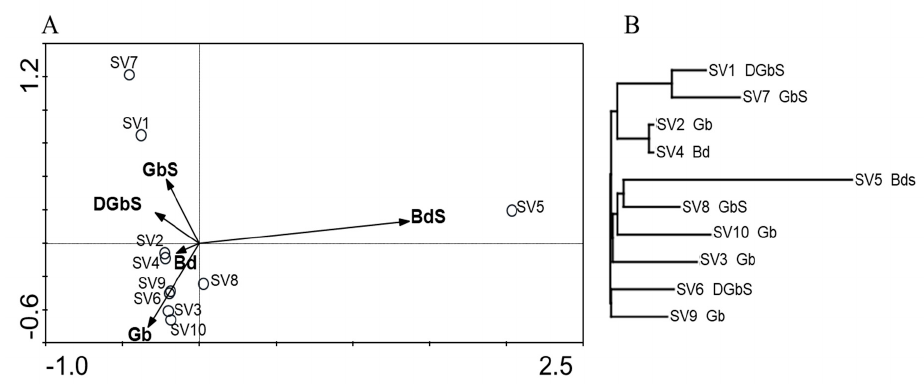
Figure 3. ( A ) Principal component analysis (PCA) and ( B ) neighbor − joining dendrogram based on the Euclidean distance for domain Bacteria Operational Taxonomic Units (OTU) profiles. Biofilm classification was used as an environmental variable for PCA and is displayed with each sample designation in the dendrogram (GbS: Green biofilm with visible salt efflorescence; Gb: Green biofilm; DGbS: Dark and green biofilm with visible salt efflorescence; Bd: Black discoloration).